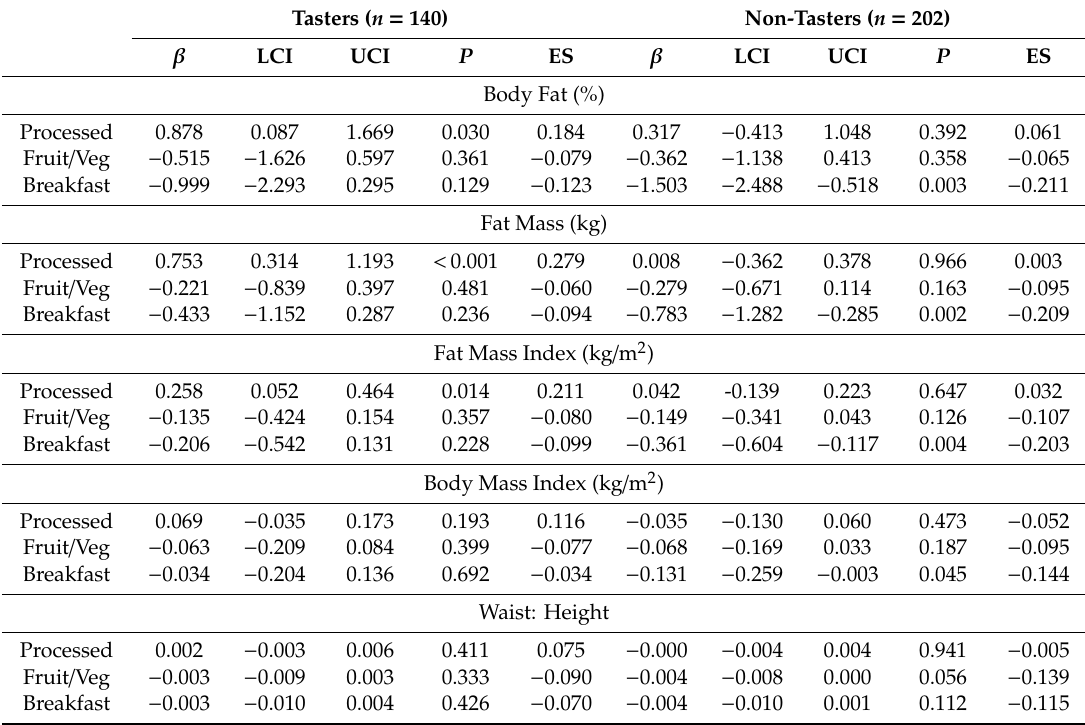
Table 4. Linear associations between body composition measures and food types stratified by